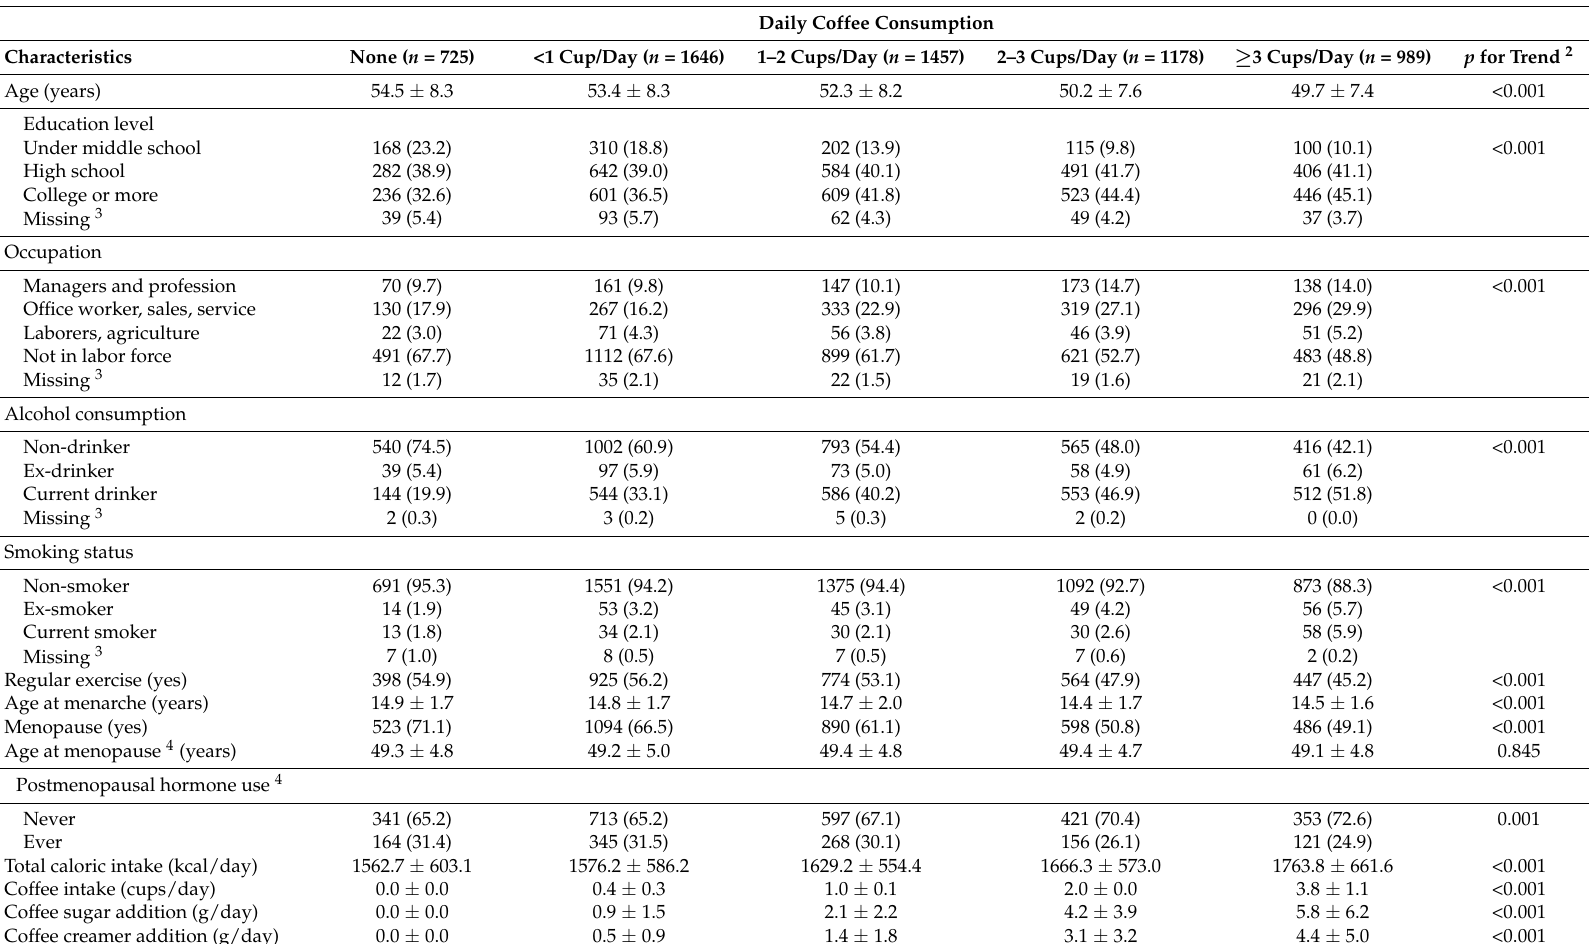
Table 1. General characteristics of the study participants stratified by coffee consumption category 1